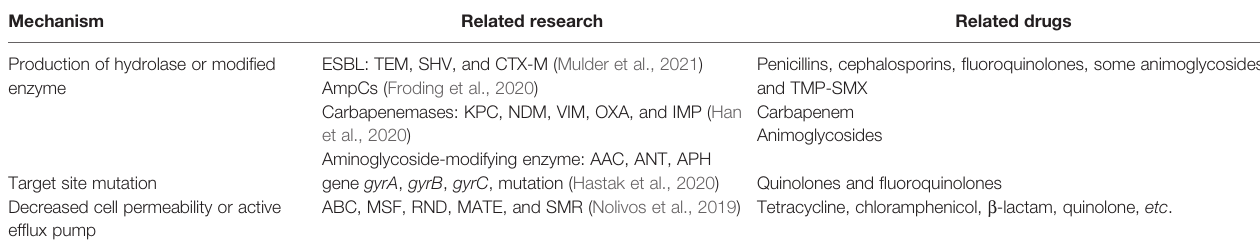
TABLE 1 | The main mechanism of drug resistance in E. coli